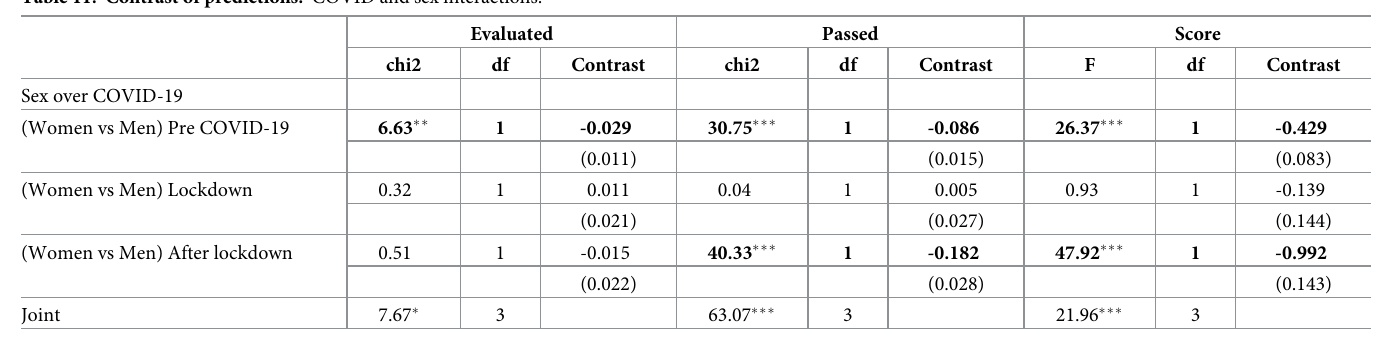
Table 11. Contrast of predictions. COVID and sex